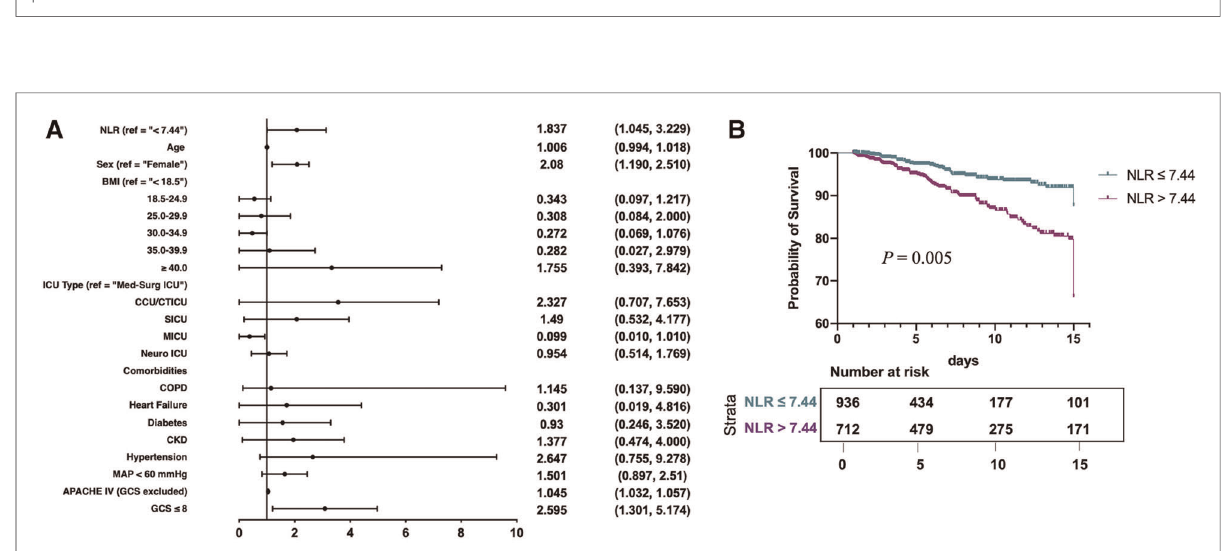
FIGURE 3 Comparison of ICU mortality and the length of ICU stay between TBI patients with NLR ≤ 7.44 and NLR>7.44 in different subgroups: ( A – C ) the ICU mortality of TBI patients with NLR>7.44 was higher than those with of NLR ≤ 7.44 at the same sex or the same age phases or the same GCS score level, and ( D – F ) the length of ICU stays of TBI patients with NLR>7.44 was longer than those with of NLR ≤ 7.44 at the same sex or the same age phases or at the same GCS score level.